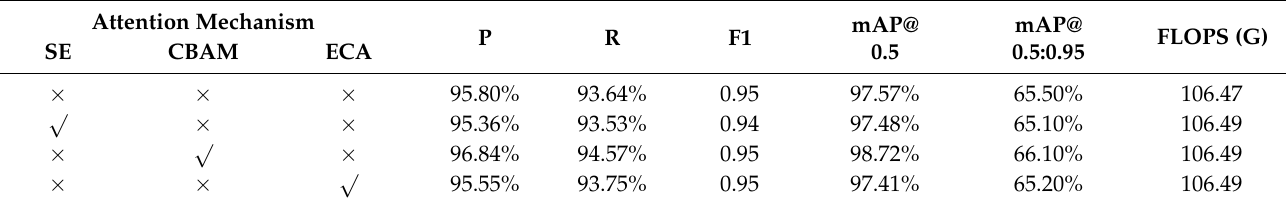
Table 3. Comparative experiments.